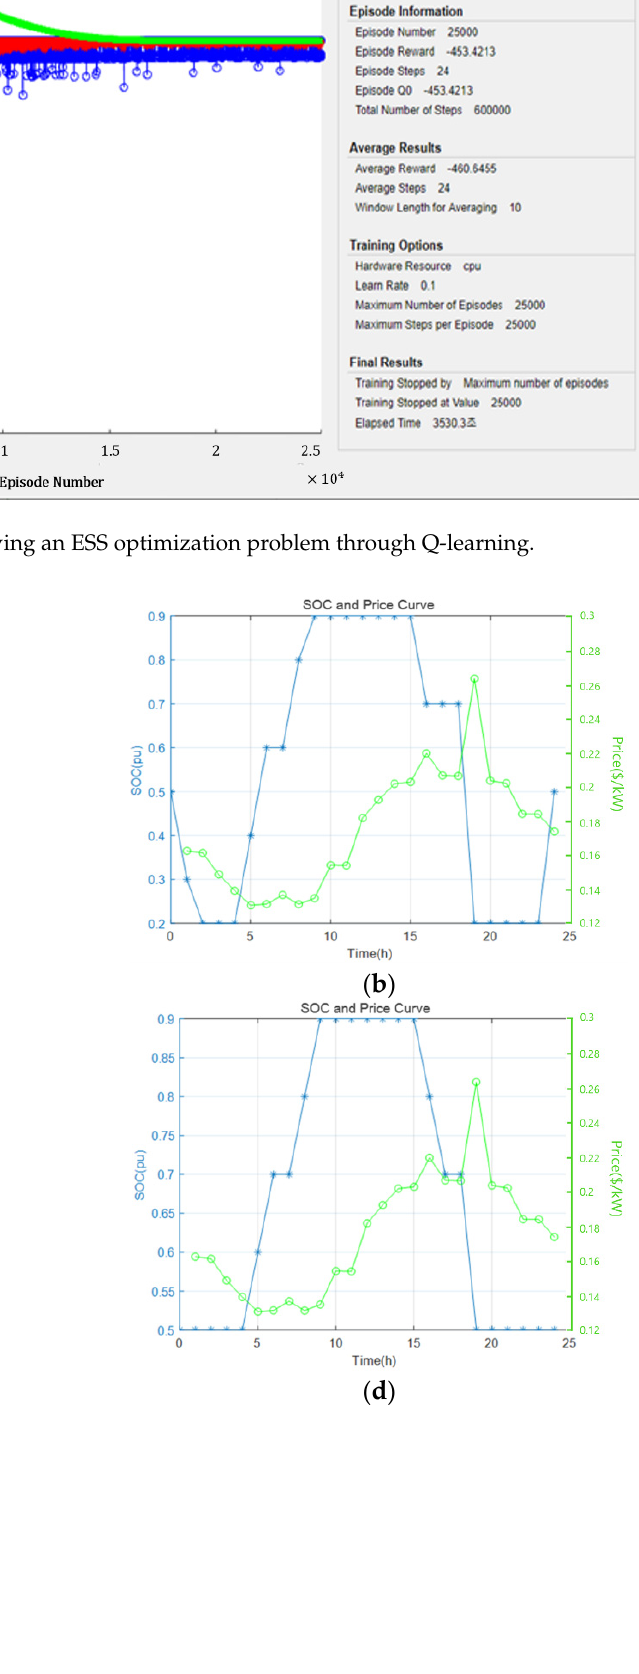
( f ) Figure 17. ( a ) SOC graph when life-cycle cost is not considered; ( b ) SOC graph when life-cycle cost weight is 0.1; ( c ) SOC graph when life-cycle cost weight is 0.4; ( d ) SOC graph when life-cycle cost weight is 0.5; ( e ) SOC graph when life-cycle cost weight is 0.6; ( f ) SOC graph when life-cycle cost weight is 0.8. However, in Figure 17b–e, when the life-cycle cost is considered, frequent charg- ing/discharging is reduced. As the life-cycle cost weight increases, discharge is not per- formed even in a time period when the price is low. It was also confirmed that no charg- ing/discharging was performed when the weight of the life-cycle cost increased by more than a certain amount in Figure 17f. This is because the investment cost value of the ESS itself dominates the difference between the system purchase cost and absolute size.